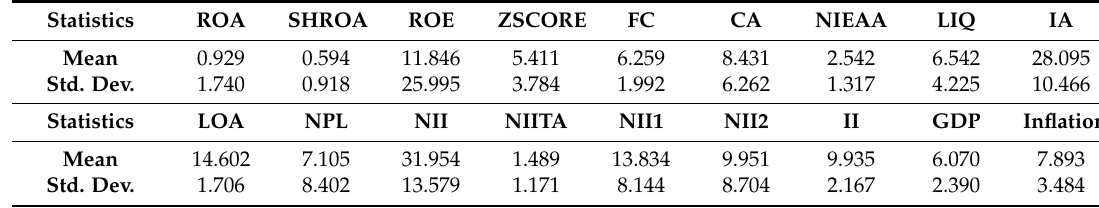
Table 2. Descriptive statistics sample